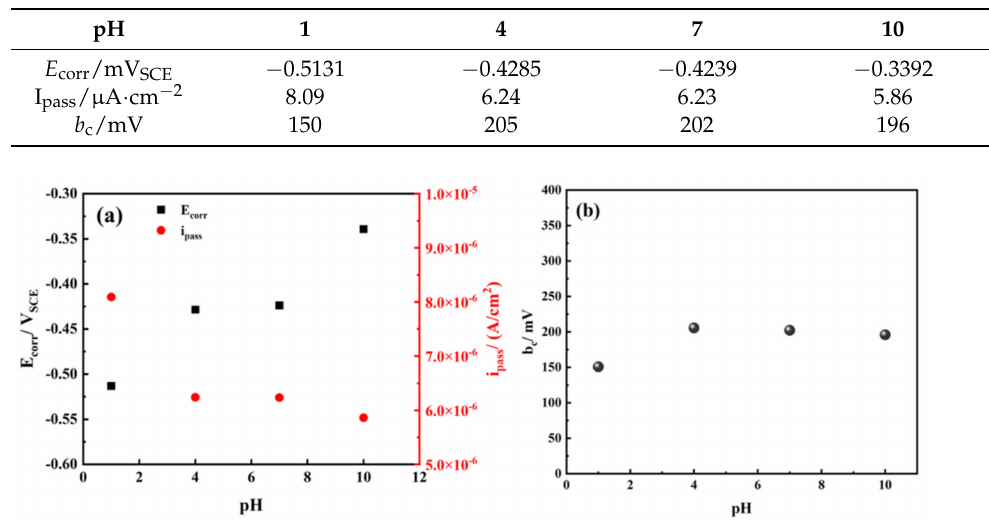
Table 1. Polarization parameters of TA2 in simulated seawater with different pH values.